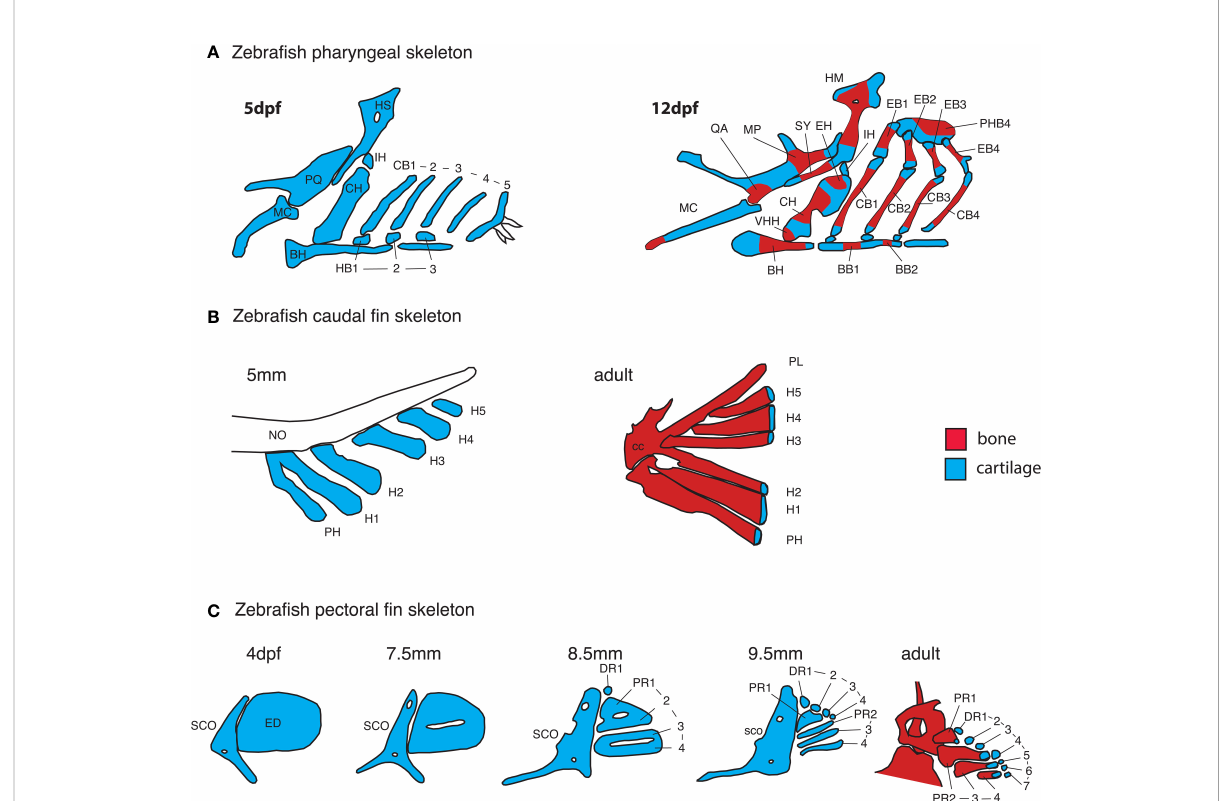
FIGURE 4 Early anatomy of zebra fi sh endochondral growth zones. (A) Endochondral growth zones start to appear in the zebra fi sh skeleton around 12days post-fertilization (dpf). One or more ossi fi cation centers appear on each bone. Unossi fi ed cartilage regions at bone ends become unidirectional growth zones, while those fl anked by ossifying cartilage become bidirectional growth zones. In the 12dpf pharyngeal skeleton, the QA and MP bones ossify over the PQ cartilage, the HM and SY bones ossify over the HS cartilage, the HH, CH and EH bones ossify over the CH cartilage, BB1 and 2 ossify over the BB cartilage. Single ossi fi cations appear on other pharyngeal bones. (B) In the caudal fi n endoskeleton, single ossi fi cations appear on each cartilage element, resulting in a single distal endochondral growth zone per element. (C) In the pectoral fi n endoskeleton, the endoskeletal disc is progressively carved into four proximal- and seven distal radials. Ossi fi cation of each proximal radial leaves a single endochondral growth zone at the distal end. Distal radials do not ossify. BB, basibranchial; BH, basihyal; CB, ceratobranchial; CC, compound centrum; DR, distal radial; ED, endoskeletal disc; H, hypural; HB, hypobranchial; IH, interhyal; MC, Meckel ’ s cartilage; NO, notochord; PH, parhypural; PHB, pharyngobranchials; PR, proximal radial; SCO, scapulocoracoid, VHH, ventral